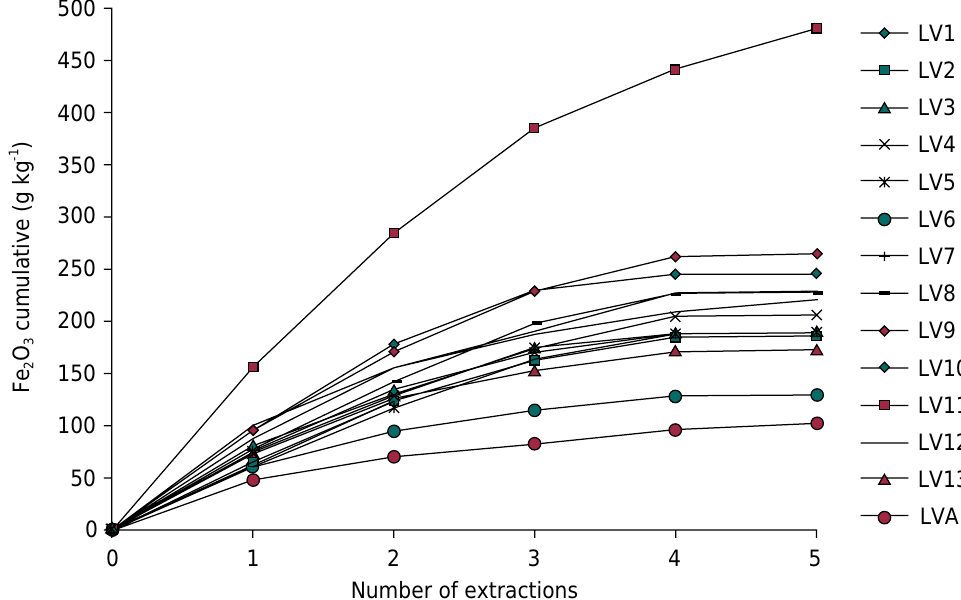
Figure 3. Cumulative iron content throughout the five sequential extractions with citrate-bicarbonate-dithionite in the clay